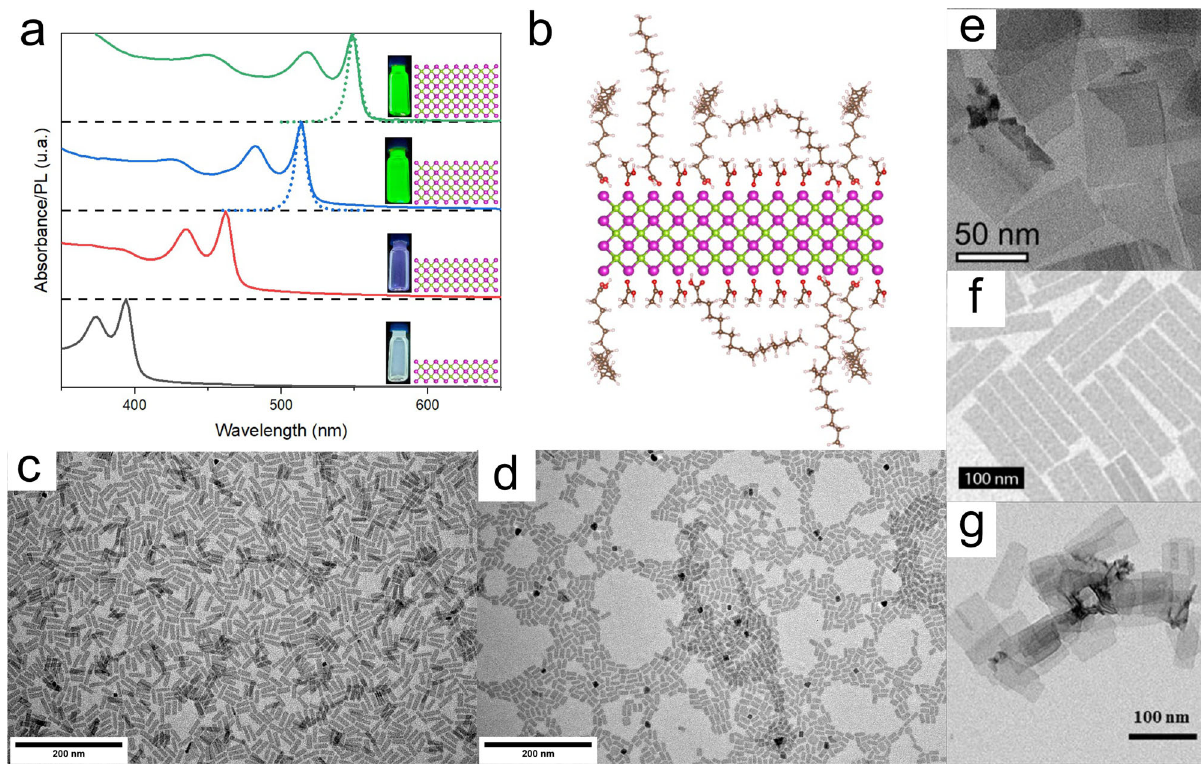
Fig. 1 Optical Properties, surface ligands, and electron microscopic images of fl at semiconducting NPLs. a UV-vis absorbance (full line) and fl uorescence (dotted line) spectra of 2 to 5 ML CdSe NPLs (from bottom to top). b Schematic representation of the cross-section of a 3 ML CdSe NPL with oleic acid and acetate ligands on its surface. Magenta corresponds to Cd, green to Se, red to O, brown to C, and white to H. c – g TEM images of c 4 ML CdSe NPLs, d 5 ML CdSe NPLs, and e 4 ML CdSe NPLs with a monolayer of CdS. Reprinted with permission from ref. 29 . Copyright 2013